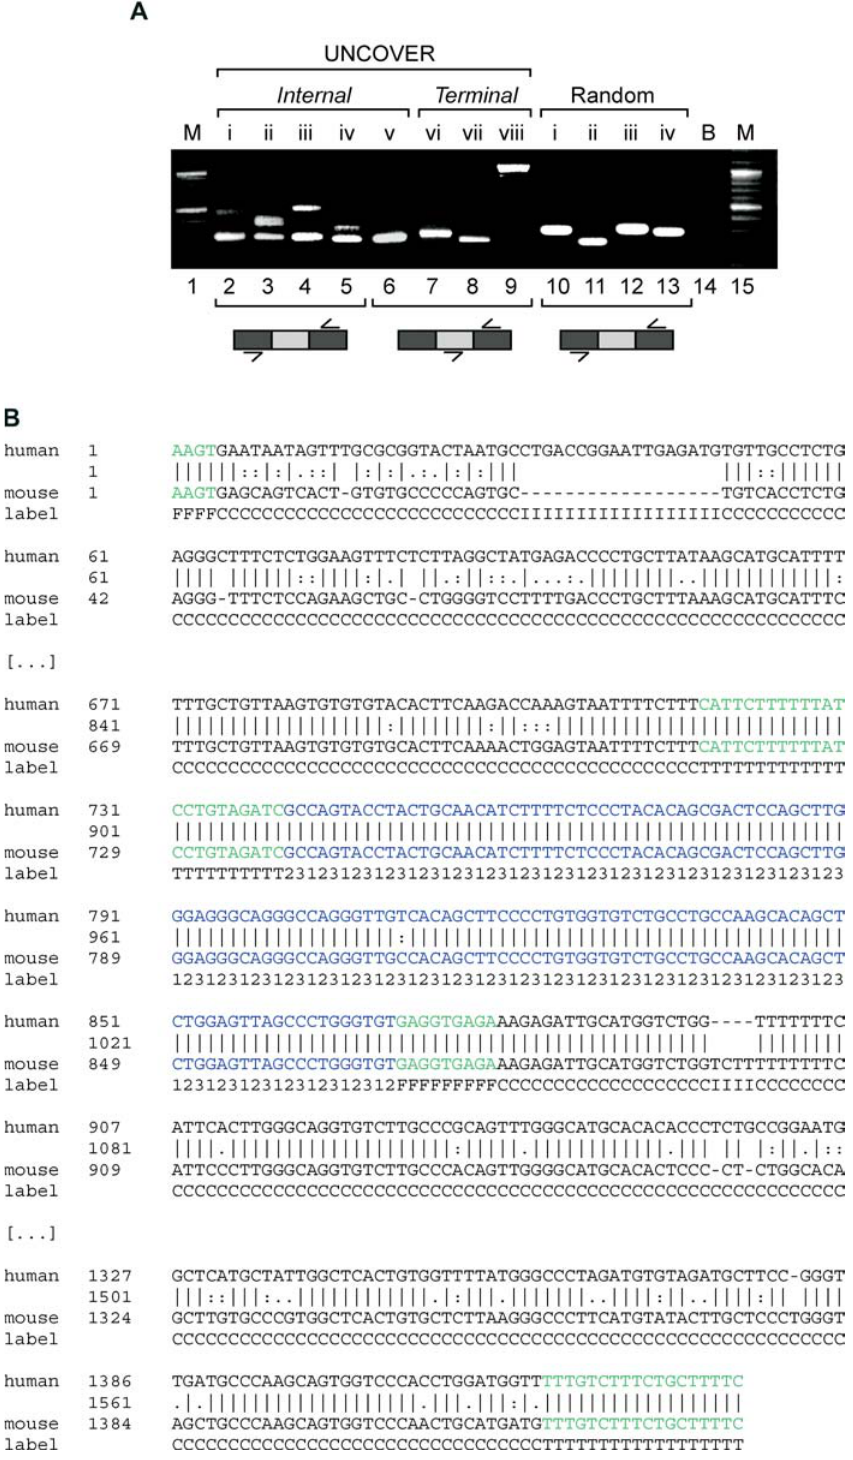
Figure 2. Experimental Validation of UNCOVER Predictions (A) RT-PCR validation of newly identified alternative exons with no prior EST evidence. Lane numbers are given in Arabic numerals below the gel; sample numbers of new verifications and negative controls are in Roman numerals above. Lanes 2–5 were verified using flanking primers and therefore show two bands each, the larger one corresponding to the event including the newly identified ACE. Lanes 6–9 used a primer internal to the newly identified exon and therefore only show one band each. Lanes 10–13 are typical examples of ten randomly selected introns in the ENCODE target regions that were not predicted to harbor AS events. Lane 14 shows a blank reaction control without adding template. Lanes 1 and 15 contain size markers spaced at 100 nt intervals, with the strong bands corresponding to 1,000 and 500 nt. Ensembl ID pairs for the known exon upstream of the validated new one and the corresponding gene are as follows: internal exons, lanes 2–6: ENSE00000881911.1:ENSG00000004866.5, ENSE00000862512.1:ENSG00000126217.3, ENSE00001201432.1:ENSG00000168781.5, ENSE00001146476.1:ENSG00000168781.5, and EN-